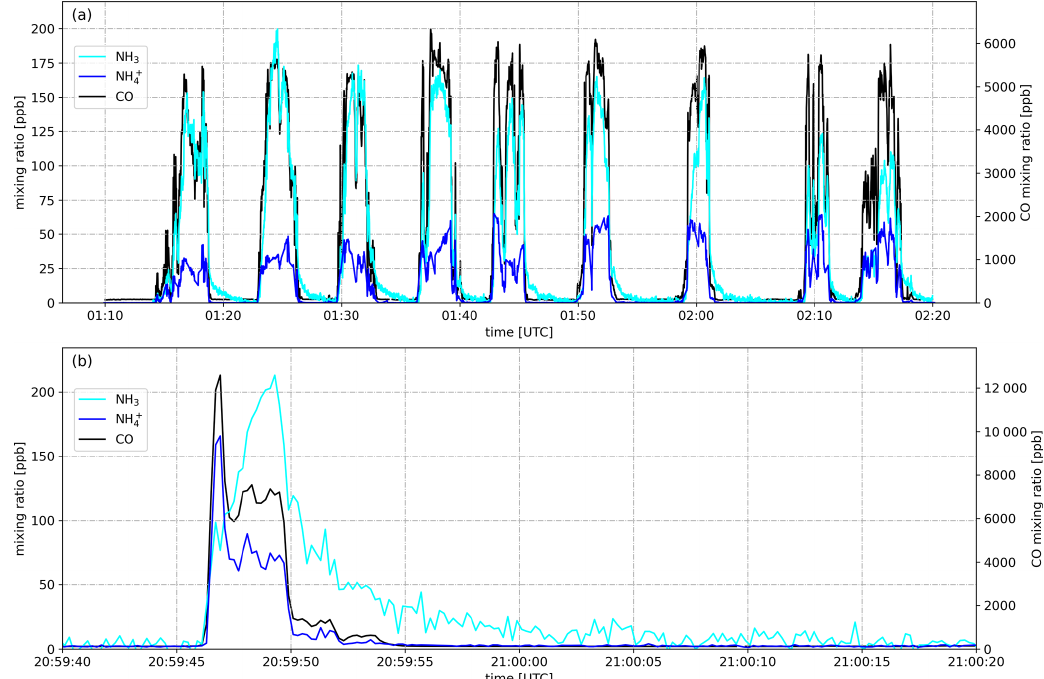
+ , and CO as measured when the NASA DC-8 transected (a) the plume emitted from the Williams Figure 4. Mixing ratios of NH 3 , NH 4 Flats Fire on 7 August 2019 in downwind direction and (b) the plume emitted from a small corn field fire in the Mississippi River valley on 26 August